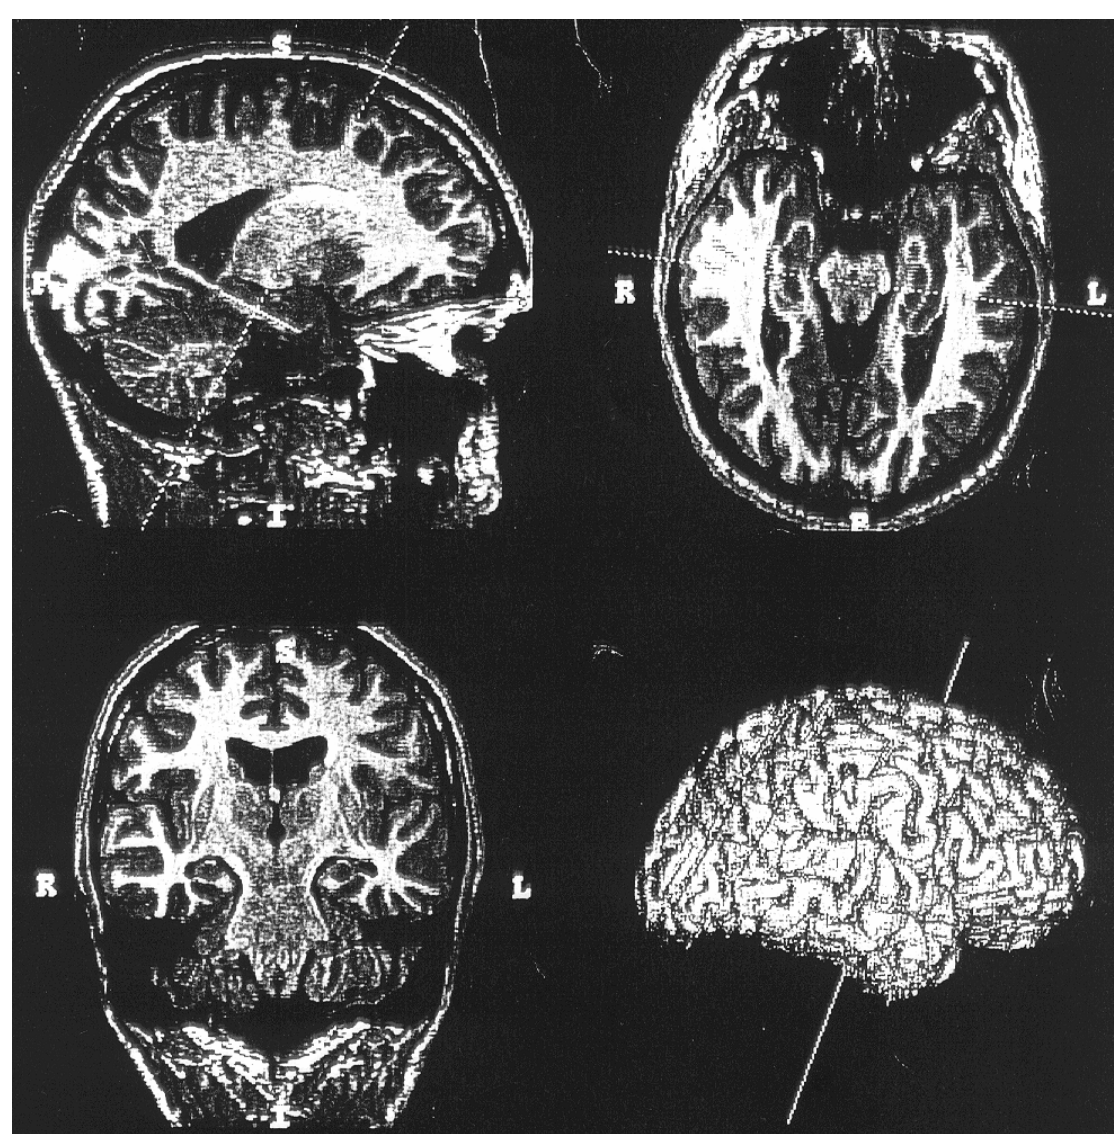
Fig. 1. For optimum visualisation of the structures of the medial temporal lobe the acquired images were reformatted perpendicular to the long axis of the hippocampus. The procedure involved (top-left) drawing a line along the long axis of the hippocampus from a sagittal slice on which this is clearly visible and (top-right) making adjustments so as to render the data symmetrical using an axial slice. A resulting coronal slice after reorientation is shown in (bottom-left), and (bottom-right) shows a 3-dimensional rendering of the brain with the plane of reorientation